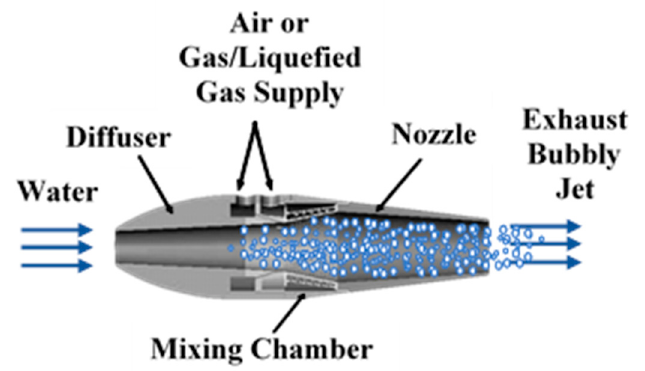
Figure 1. Schematic illustration of the marine two-phase ramjet fed by air or liquefied gas.